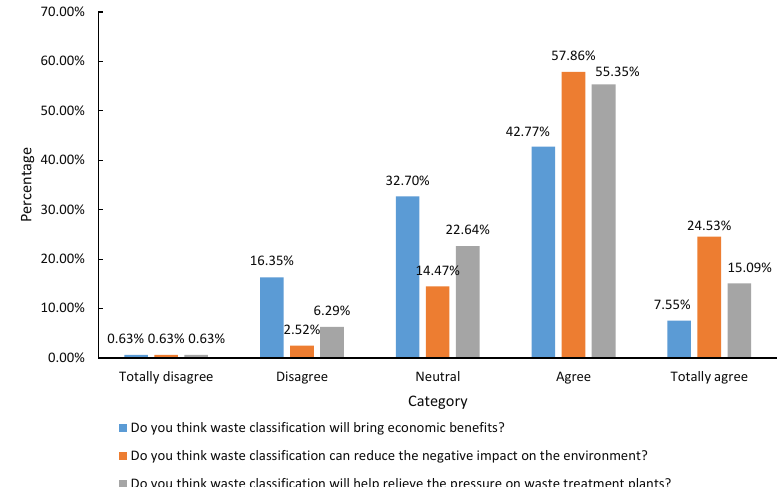
Figure 4. Farmers’ behavior in terms of private benefits.